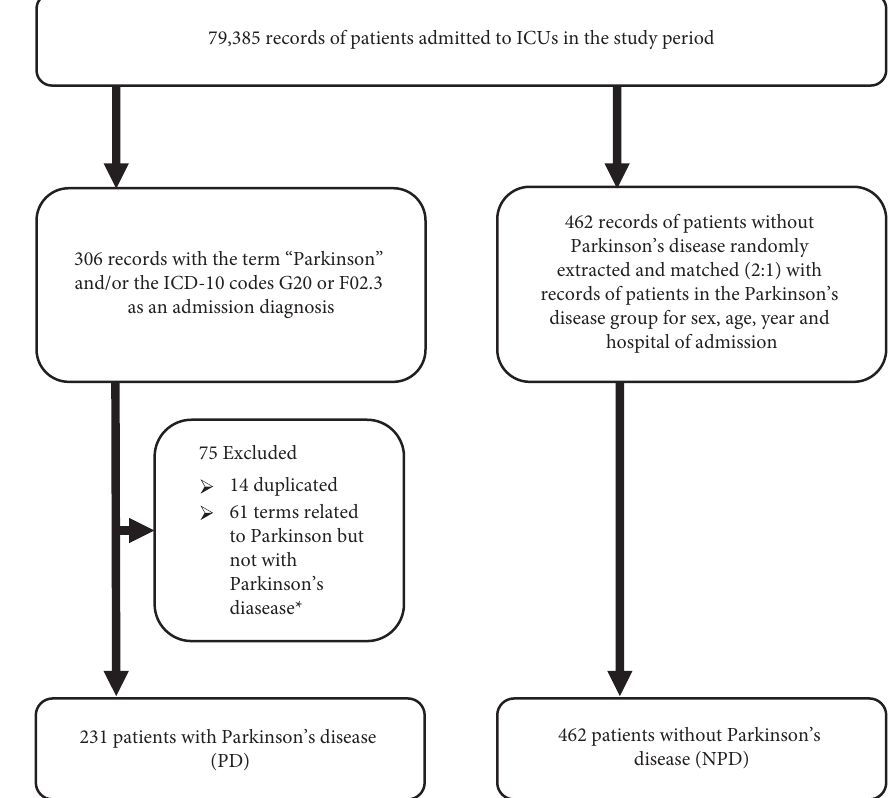
Figure 1: Sample selection flowchart. ∗ Records with the following terms related to Parkinson but not to Parkinson’s disease were excluded: “secondary Parkinsonism,” “preexcitation syndrome (Wolff–Parkinson–White syndrome),” “accidental poisoning by and exposure to antiepileptic, sedative-hypnotic, anti-Parkinsonism, and psychotropic drugs, not elsewhere classified,” “intentional self-poisoning by and exposure to antiepileptic, sedative-hypnotic, anti-Parkinsonism, and psychotropic drugs, not elsewhere classified,” and “poisoning by and exposure to antiepileptic, sedative-hypnotic, anti-Parkinsonism, and psychotropic drugs, not elsewhere classified, undetermined intent.”